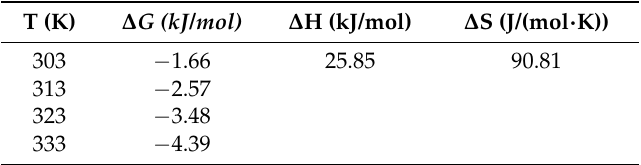
Figure 5. Thermodynamics analyses of the adsorption of MB on GO-COOH sponge. ( a ) Adsorption as a function of contact temperature. Data represent mean ± SD ( n = 3). ( b ) Thermodynamic analysis. Table 3. Thermodynamics parameters of the adsorption of MB on GO-COOH sponge.